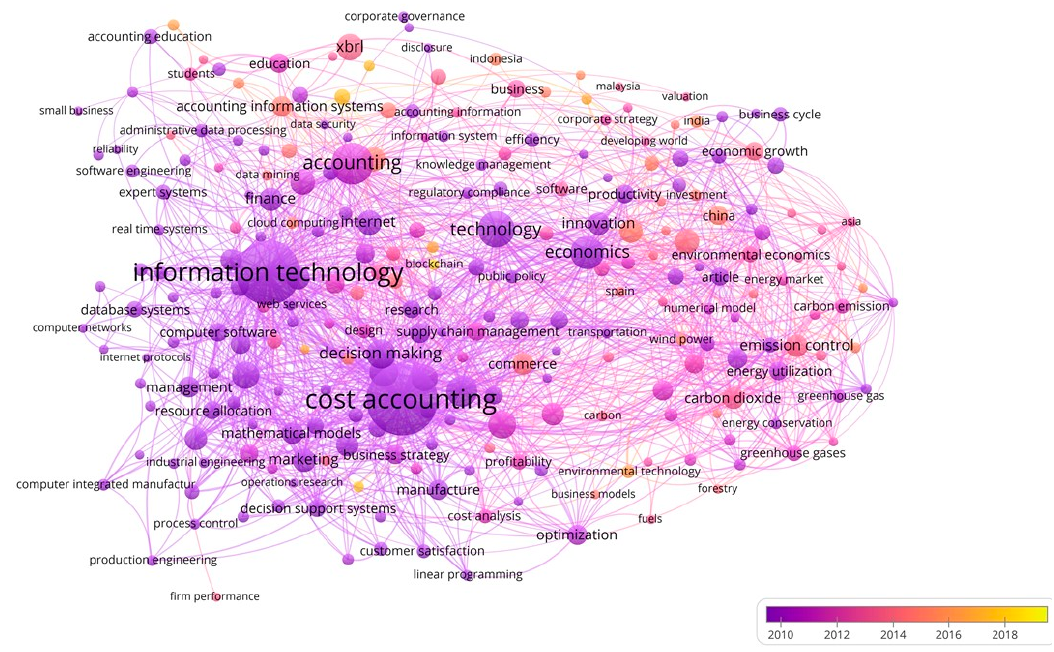
Figure 6. Evolution of the network of keywords based on the co-occurrence method (1961–2019).